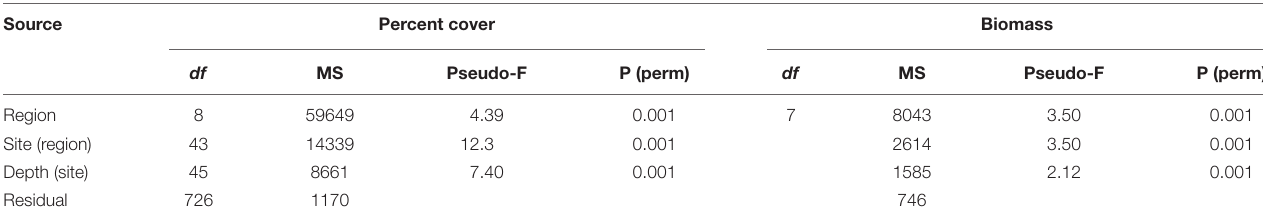
TABLE 1 | Permutational multivariate analyses of variance, based on Bray–Curtis similarity matrices of square-root transformed percent cover and average biomass (WW) data, at depth level and sites in each region. Source